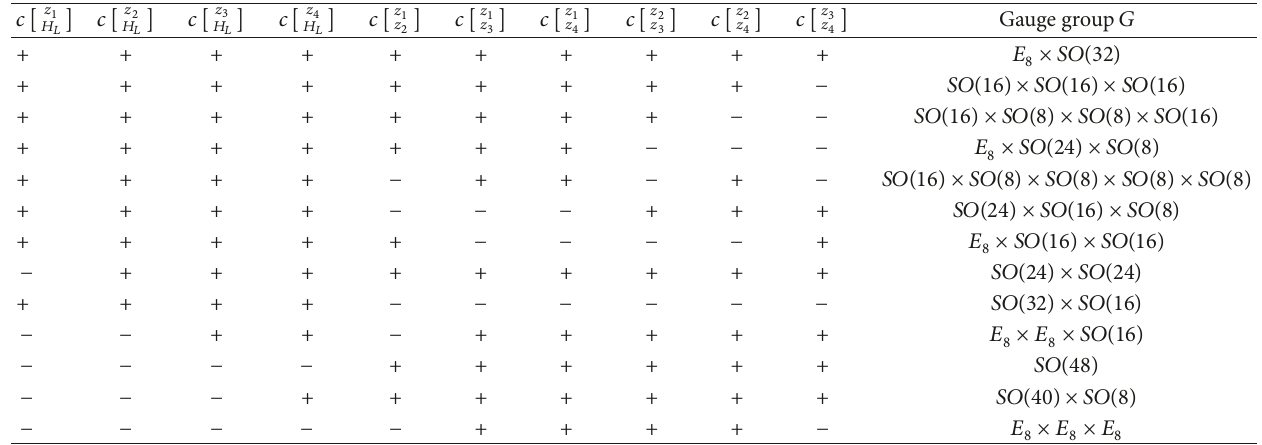
Table 3: The configuration of the symmetry group with six basis